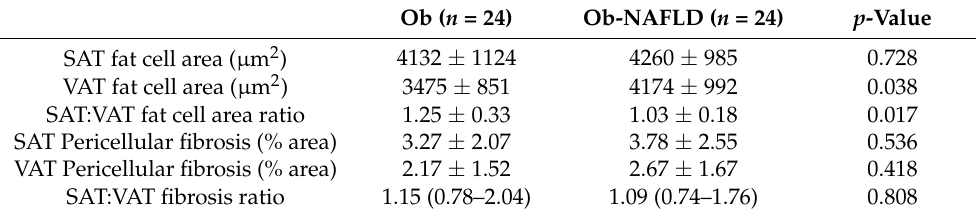
Table 2. Histological characteristics of WAT from Ob and Ob-NAFLD